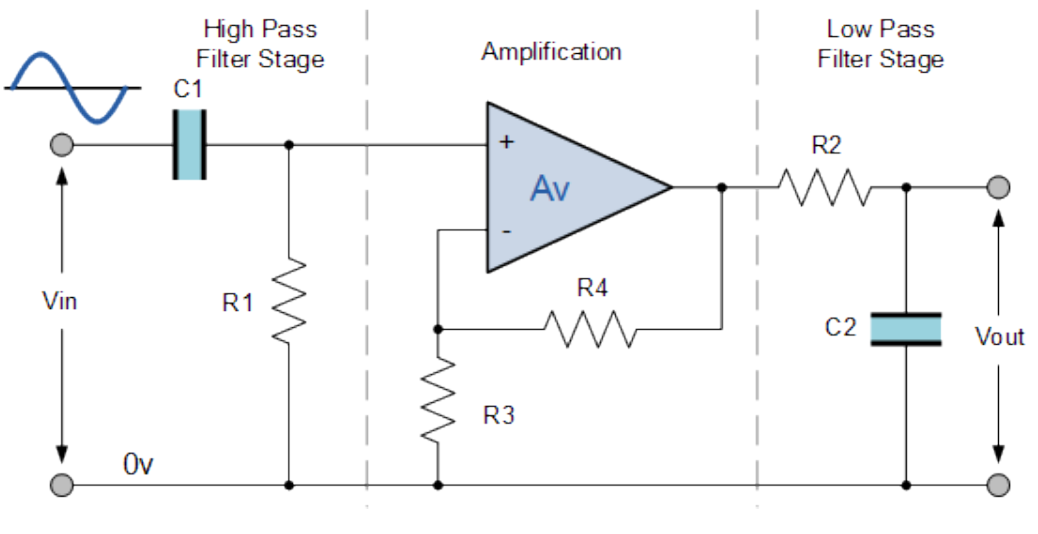
Figure 4. Active bandpass filter